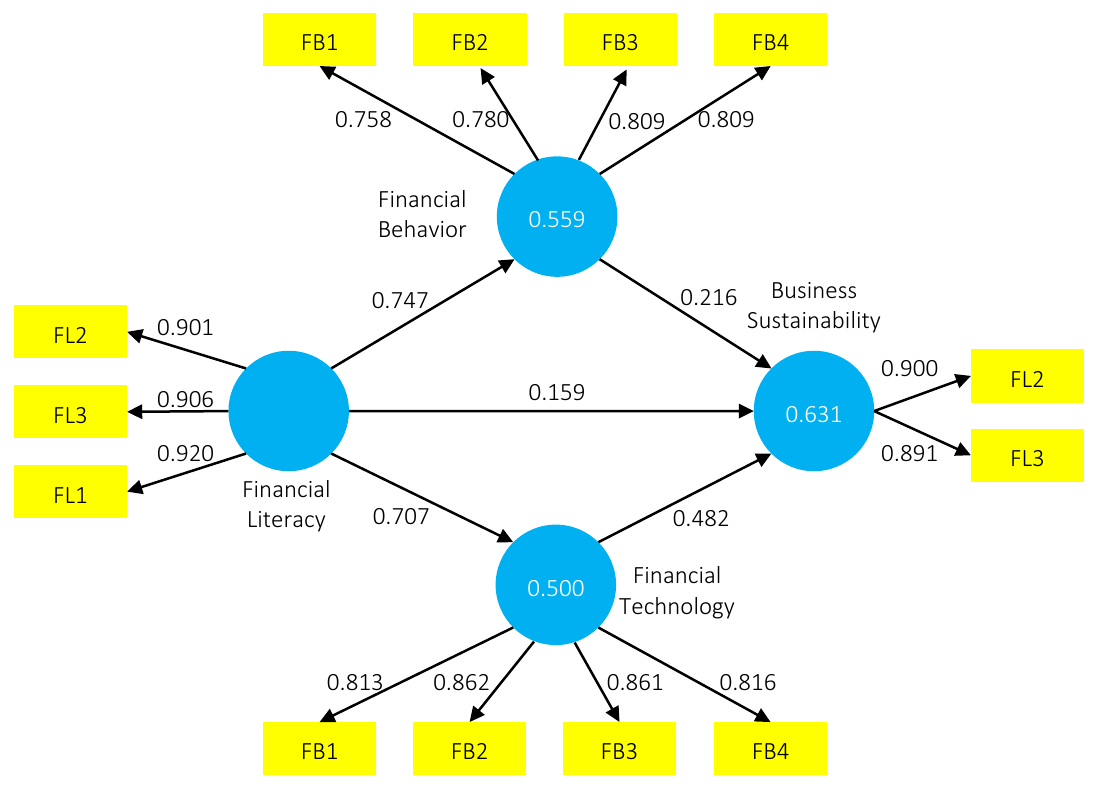
Figure 2. PLS algorithm processing